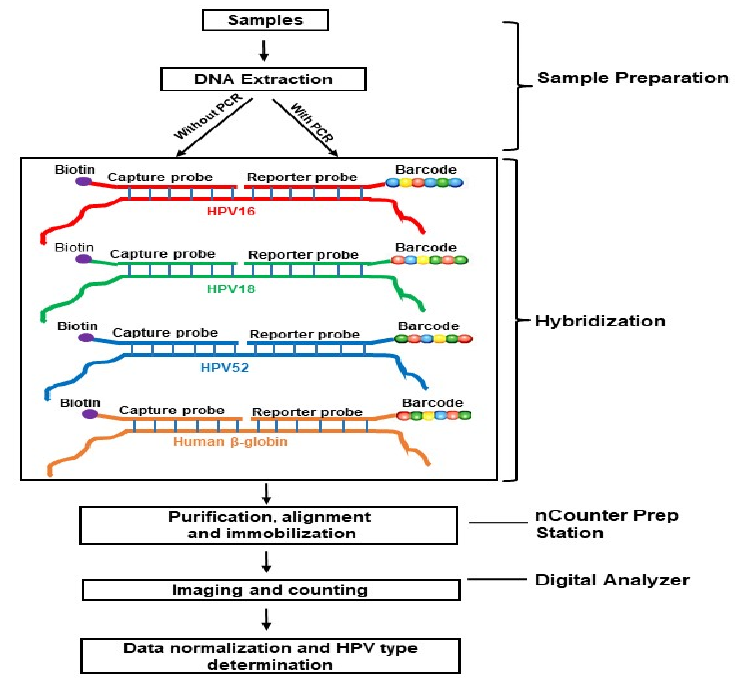
Figure 1. A schematic illustration of the conceptual framework using a sample with multiple infection of HPV types 16, 18 and 52 to evaluate NanoString technology for HPV typing. A CodeSet for an HPV type consists of sequence-specific capture and reporter probes, each 35–50 bases long. The CodeSets are hybridized to DNA extract, either directly or to amplified product. Following hybridization, the tripartide complex is purified, aligned and immobilized in a sample cartridge using the automated nCounter Prep Station. Cartridges are then transferred to the Digital Analyzer for imaging and digital counting of molecular barcodes carried in the reporter probes. HPV type determination is based on normalized count of barcodes that pass a